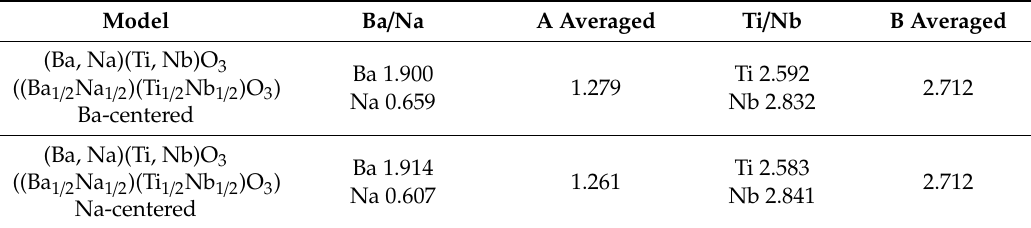
Figure 6. Histograms of the effective charges of the cations of the solid solution model (Ba, Na)(Ti, Nb)O 3 . A corresponds to (Ba, Na), and B (Ti, Nb). The values in Table 7 were used. Table 7. Effective charges of the solid solution models (Ba, Na)(Ti, Nb)O 3 . Each of the detailed chemical notations of the models is given in parenthesis in each cell on the left.